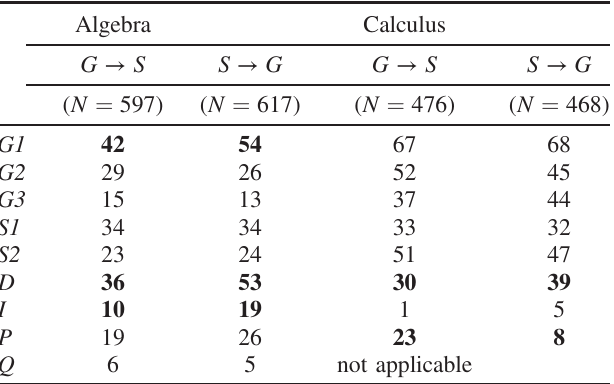
TABLE IX. Prevalence of arguments per direction of trans- lation, expressed as percentages. N is the number of items per type of direction. Significant differences in the use of arguments between the different directions are printed in